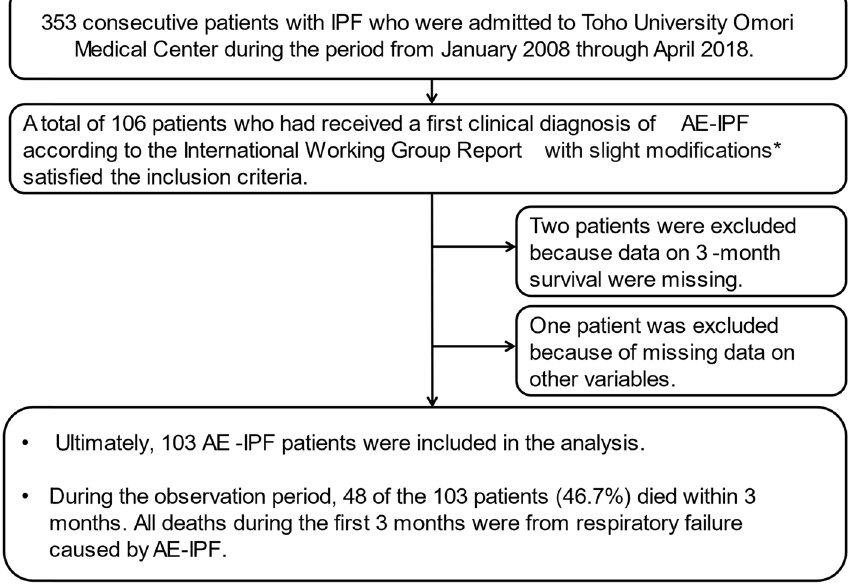
Figure 1. Flowchart of study. *AE-IPF was diagnosed when the following criteria were fulfilled (1) Previous or concurrent diagnosis of IPF, (2) Acute worsening or development of dyspnea typically < 1 month duration, (3) Computed tomography with new bilateral ground-glass opacity and/or consolidation superimposed on a background pattern consistent with UIP pattern, (4) deterioration not fully explained by cardiac failure, fluid overload (5) no evidence of pulmonary infection on bronchoalveolar lavage, endotracheal aspiration, or sputum culture and negative results on blood tests for other potentially infectious